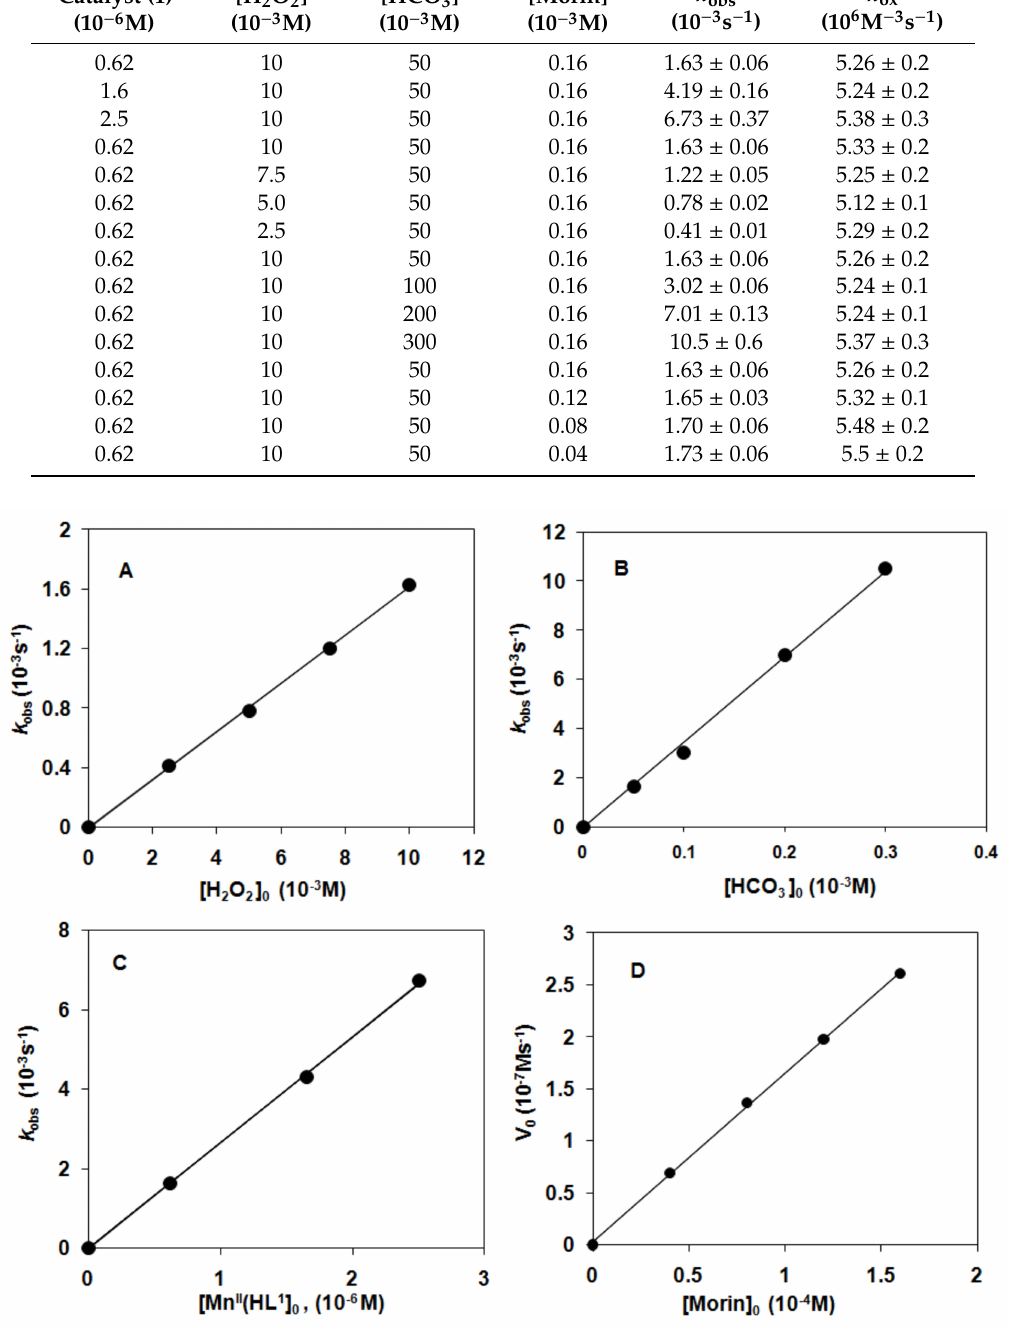
Figure 8. Catalytic oxidation of morin with [Mn(HL 1 )Cl 2 ] ( 1 ) in bicarbonate bu ff er at pH 10 and 25 ◦ C. ( A ) Dependence of the first-order rate constant ( k obs ) for morin oxidation on the H 2 O 2 concentration (Table 3). ( B ) Dependence of the first-order rate constant ( k obs ) for morin oxidation on the HCO 3¯ concentration (Table 3). ( C ) Dependence of the first-order rate constant ( k obs ) for morin oxidation on the morin concentration (Table